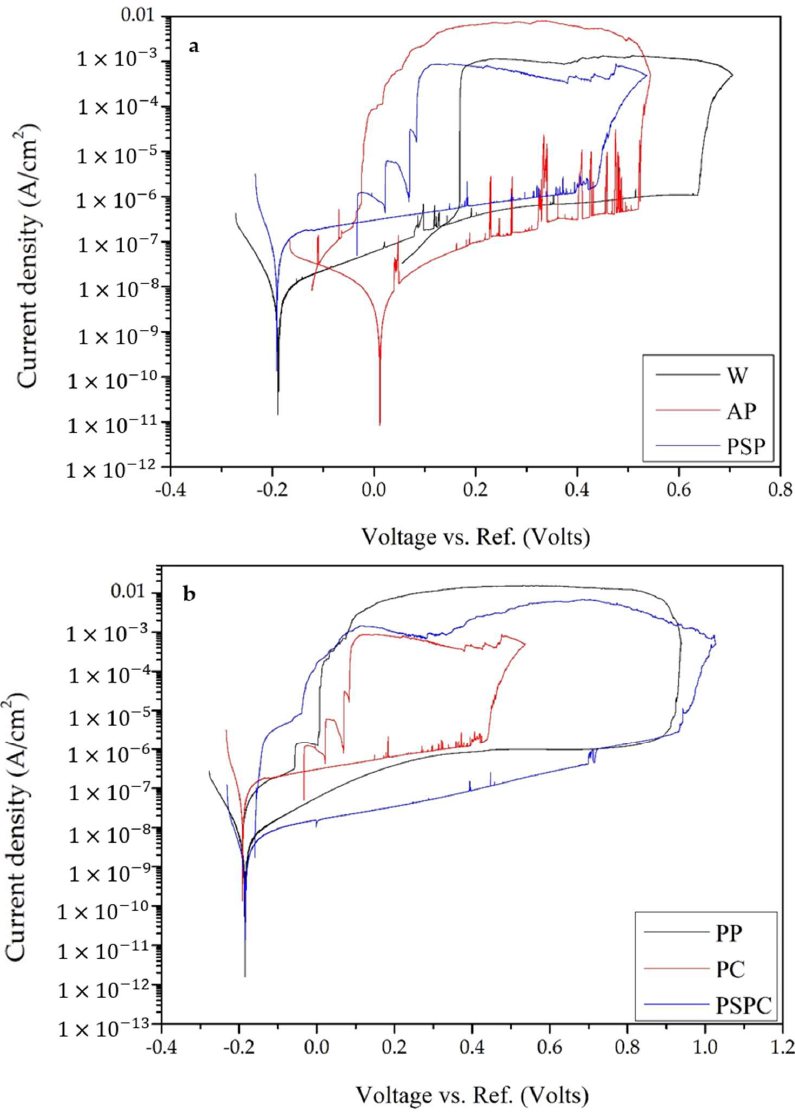
Figure 15. Representative cyclic curves for the six studied surfaces for: ( a ) Wrought, as-printed and shot peened and ( b ) polished, coated and hybrid. Table 7. Average corrosion testing results for each